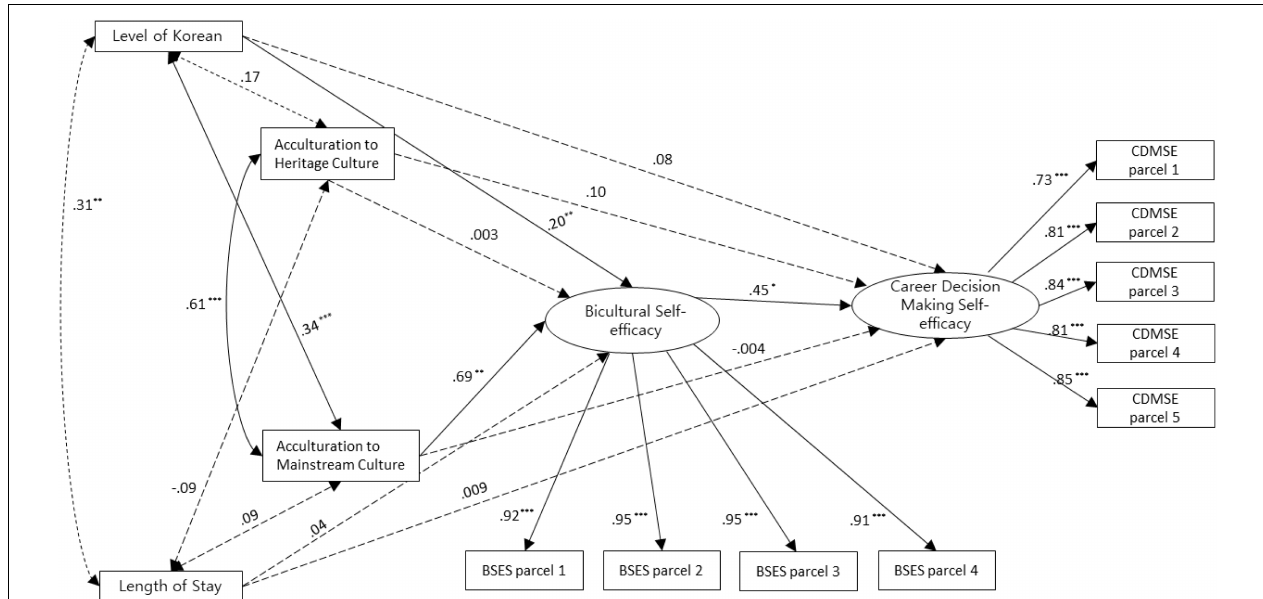
FIGURE 1 | Research design of the structural model. *** p < 0.001, ** p < 0.01, and * p <